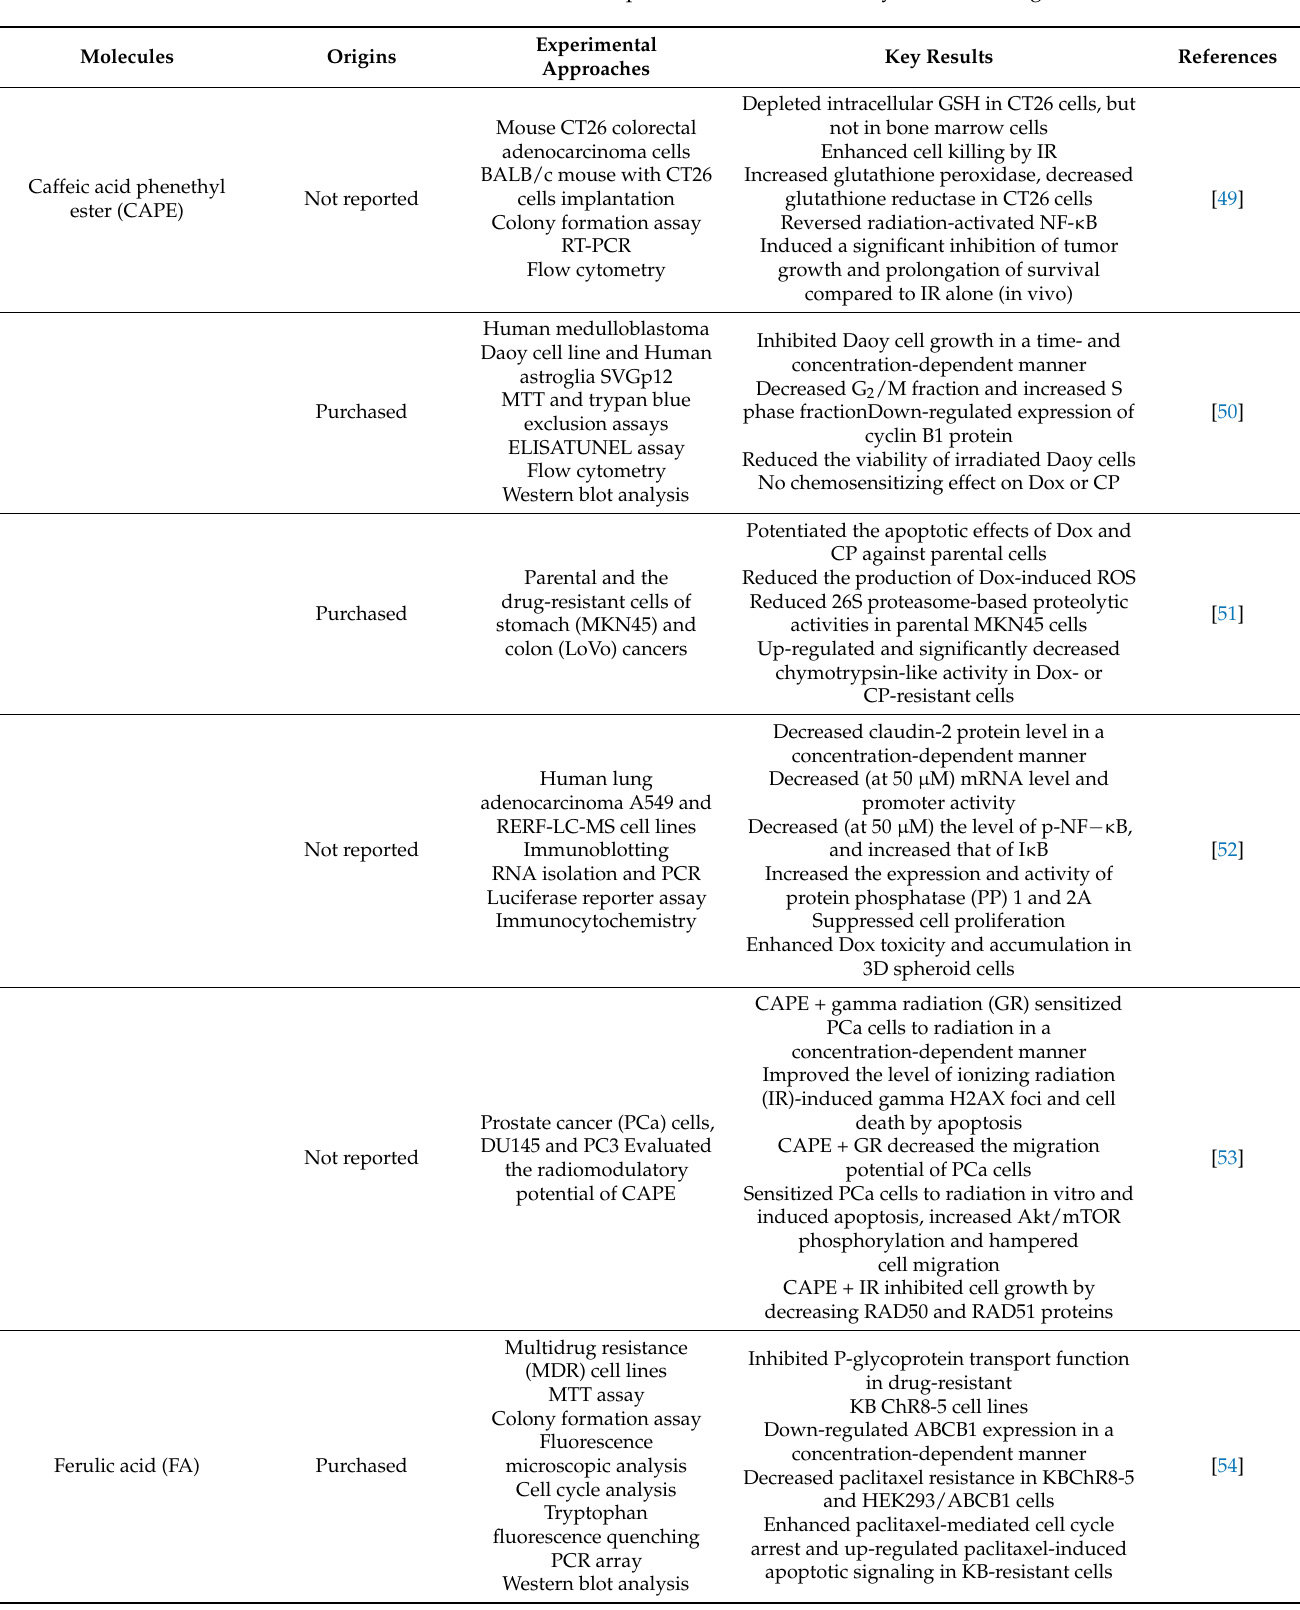
Table 3. Phenolic acids that improve the chemosensitivity of cancer